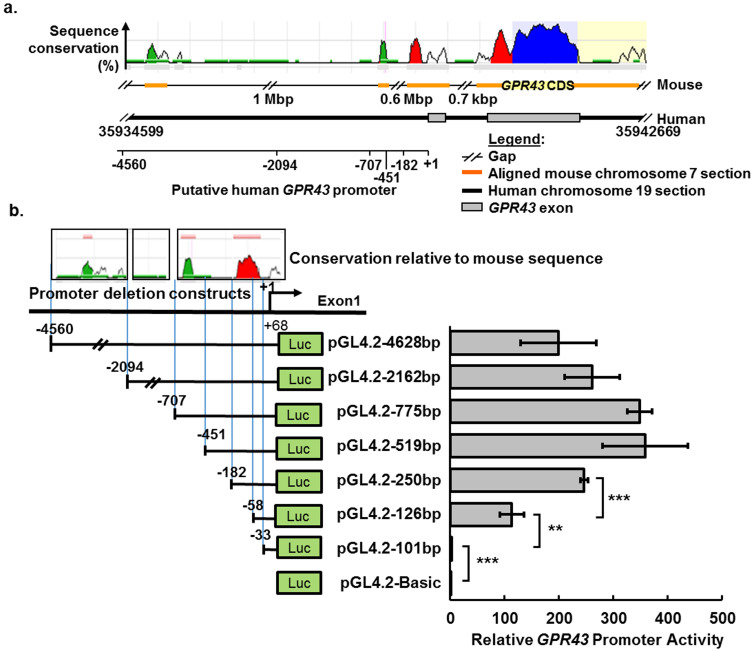
Deletions define a 519-bp putative GPR43 promoter containing the core and proximal promoter.(a) ECR Browser plot spanning −4560 bp upstream of the transcription start site (+1), the entire GPR43 gene and 2000 bp after the gene. The plot represents sequence homology of the mouse chromosome 7 (Ref Seq ID: NC_000073.6 ) region flanking the murine Gpr43 (Entrez Gene ID: 233079) in comparison to the corresponding region on the human chromosome 19 (RefSeq ID: NC_000019.9; positions: 35934599–35942669), which is acting as the baseline. Sequence lengths of >100 bp with 70% sequence conservation are shown as peaks. (b) Luciferase reporter activities of 5′ deletion constructs from a 4628 bp putative GPR43 promoter in differentiated U937 cells 22 h after transfection. Analysis of the homology with mouse sequence was used to approximate the deletion sites. Results represent the average Firefly luciferase read-outs of three independent transfections (n = 3) normalized to Renilla luciferase activity and relative to the basic (empty) luciferase vector, arbitrarily set as 1. Error bars represent the mean ± s.d.. The data shown are representative of three independent experiments. Two tailed Students' T-test was used to determine the statistical significance of the difference between promoter constructs and is annotated as: * <0.05, ** <0.01, and *** <0.001.